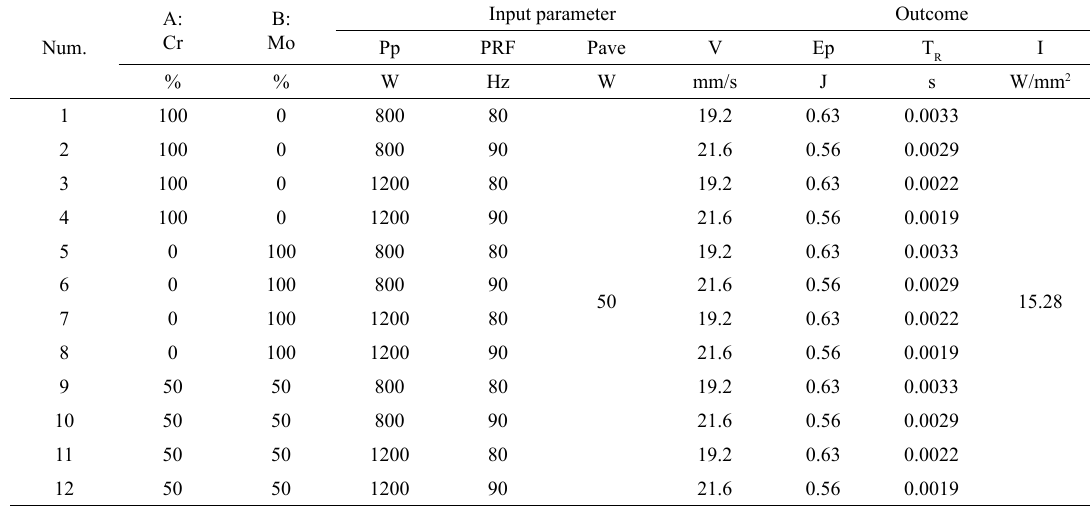
Table 2. Parameter settings for laser surface cladding of grey cast iron. Num.